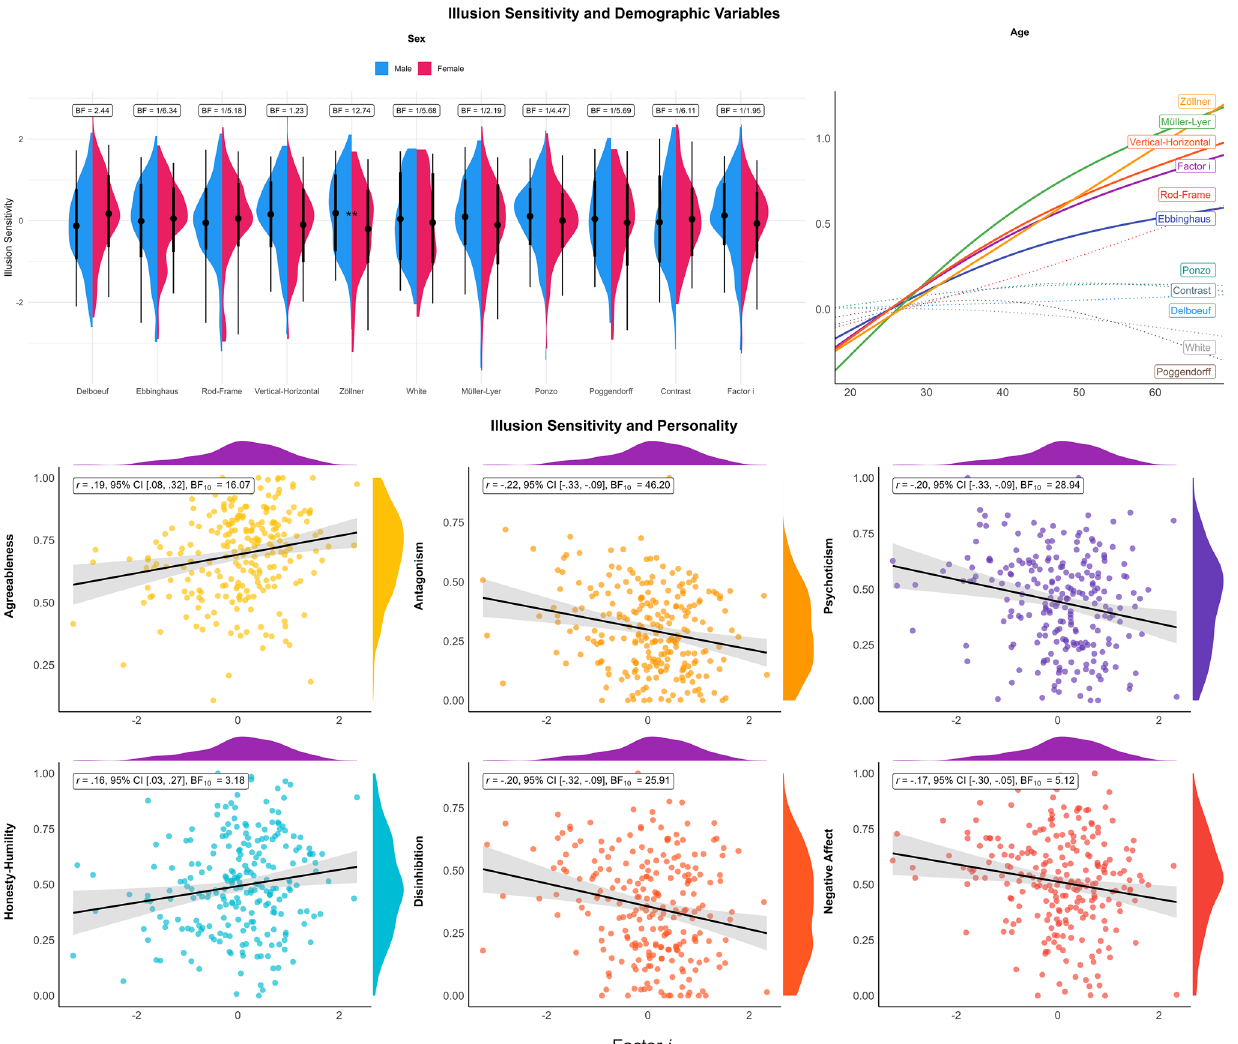
Figure 4. The upper plots show the illusion sensitivity scores as a function of sex and age (solid lines indicate significant relationships). Bottom plots show the correlation between the general factor (Factor i ) of illusion sensitivity (on the x-axes) and personality